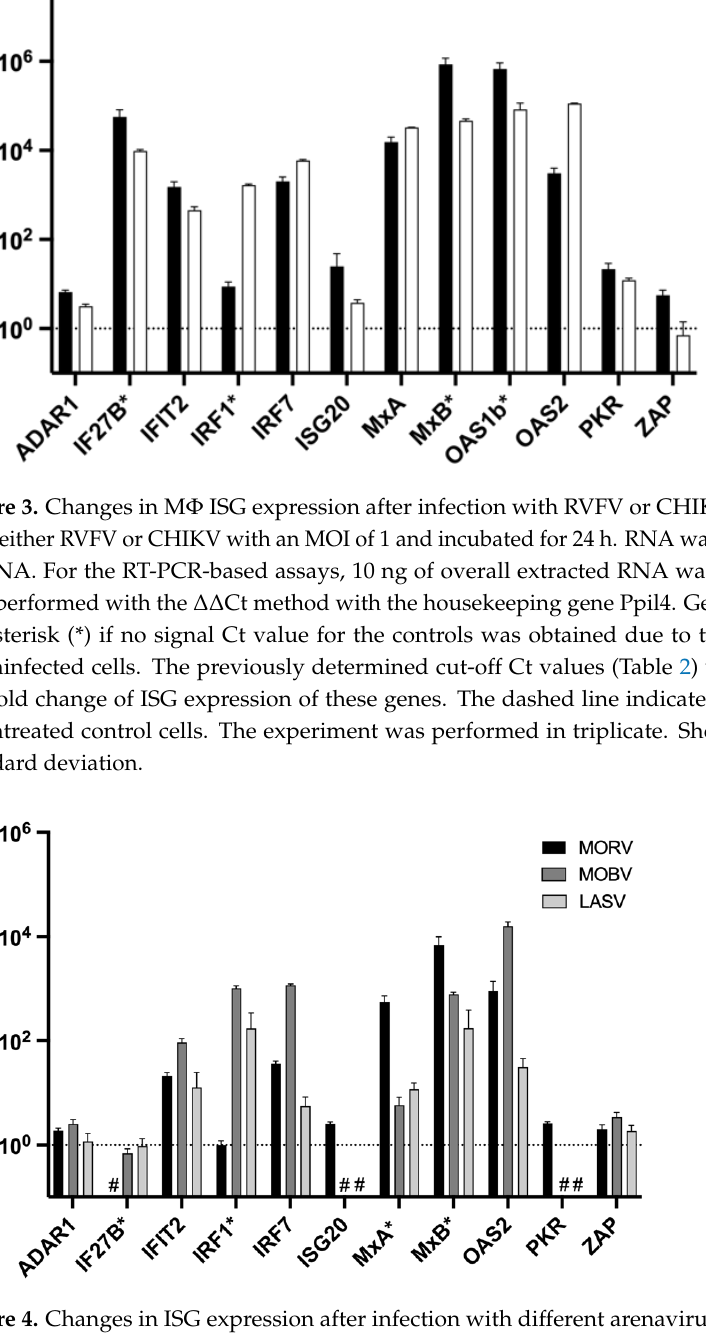
Figure 5. Infection of stimulated M Φ with LASV. M Φ were stimulated with 500 U/mL IFN- α, or IFN- β or Poly(I:C) and sixteen hours post-stimulation, they were infected with LASV with an MOI of 0.1. The cell culture supernatant was collected 24 or 48 h post-infection (h. p. i.) and used for immunofocus assay. The virus titres are shown relative to their uninfected controls. The experiment was performed in triplicate. Shown are the mean and standard deviation. Differences in virus titres were analysed with one-way ANOVA and Bonferroni ’ s multiple comparison test. *, p < 0.033; ***, p < 0.001.